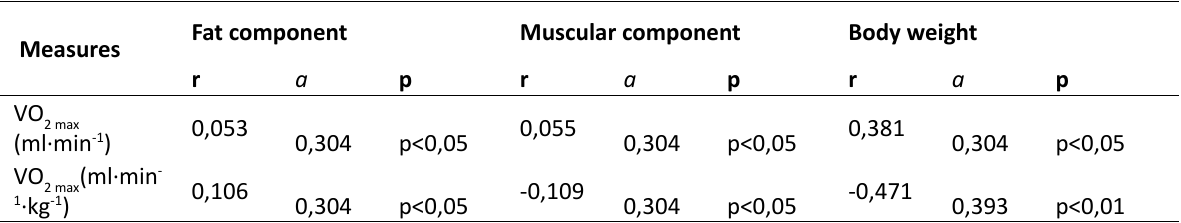
Table 4 . Interrelation of the maximum oxygen consumption with body weight and body component structure of women (ectomorphic somatotype)